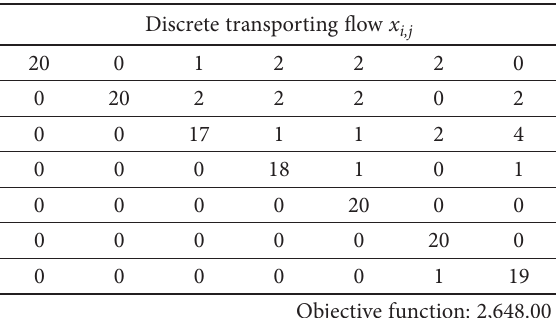
Table 8 . Best obtained discrete solution for the 7×7 test